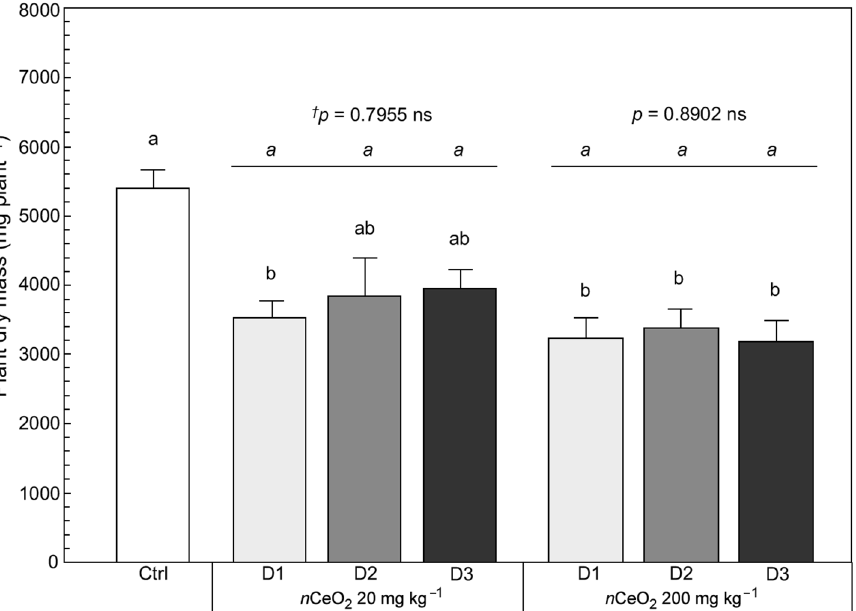
Figure 6. Plant dry mass of S. flos cuculi . Comparison of effects based on single (D1) and repeated applications (D2, D3) of 20 and 200 mg kg − 1 n CeO 2 , respectively. Letters indicate statistically significant difference between treatments ( p ≤ 0.05) using one-way ANOVA followed by Tukey’s test. † One-way ANOVA p -value within each concentration.